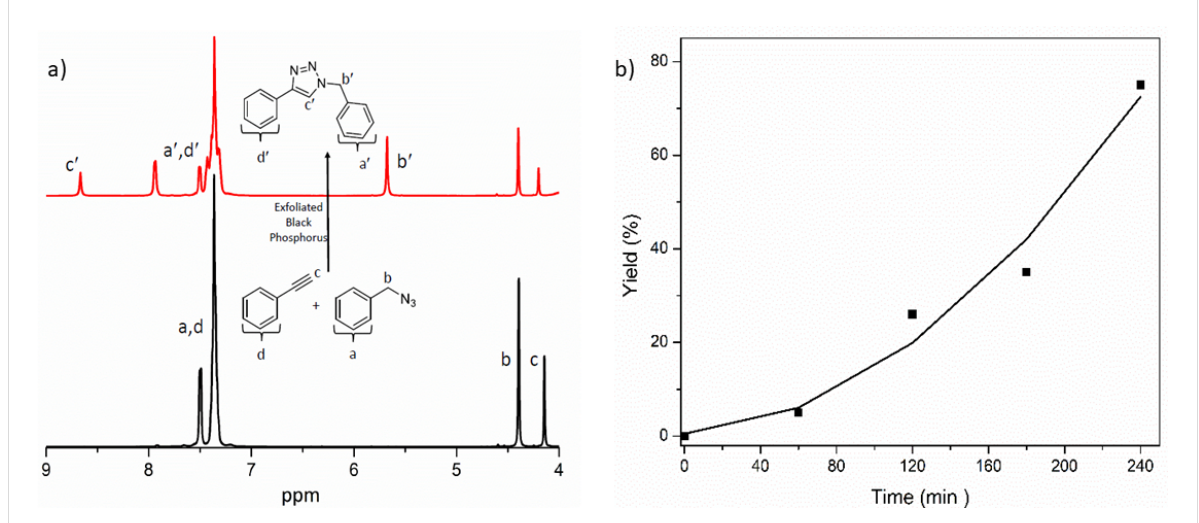
Figure 3: a) 1 H NMR spectra of the model reaction between benzyl azide ( Az-1 ) and phenylacetylene ( Alk-3 ) before (black) and after (red) irradiation. b) Conversion-time plot as measured by 1 H NMR spectroscopy through integration of the acetylene proton around 4.42 ppm.